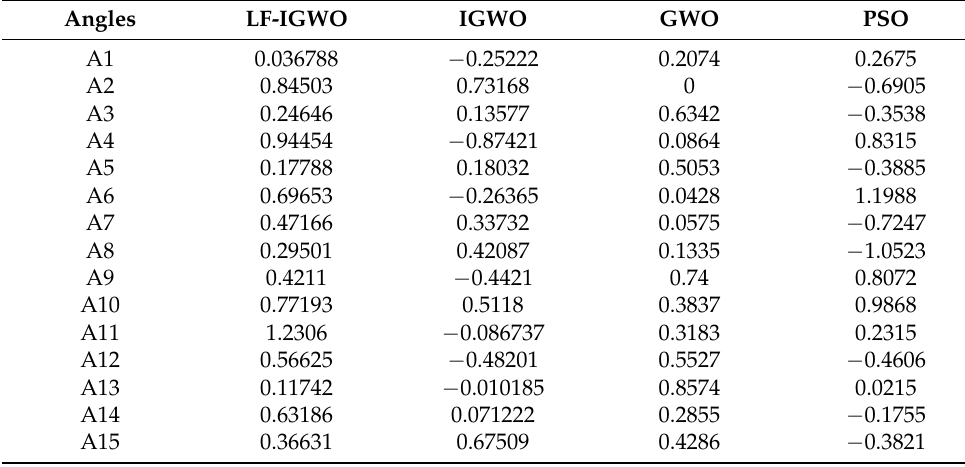
Table 8. Comparison of firing angles of LF-IGWO with other